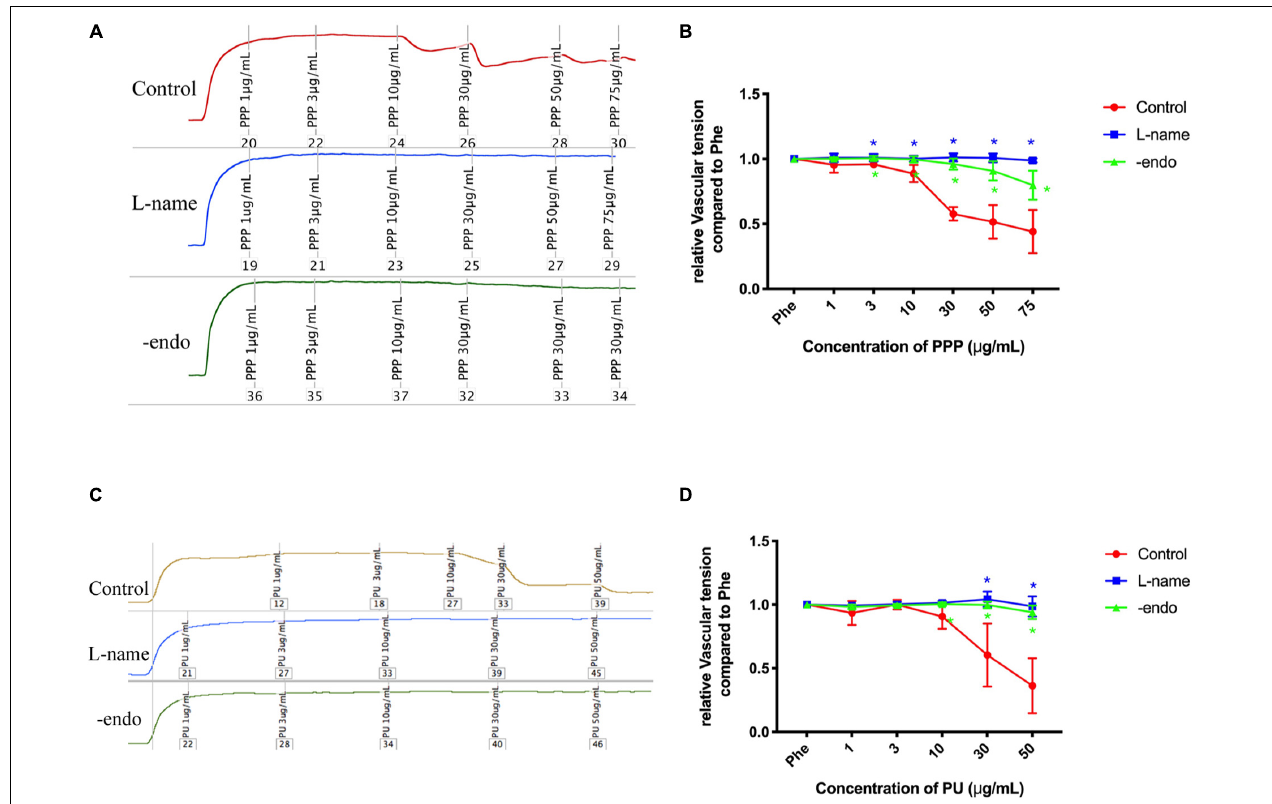
FIGURE 3 | Endothelium-dependent vaso-protective effects of PPP and PU. A-D. Endothelium-dependent vaso-protective effects of PPP (A) and PU (C) and the quantitative results [ (B,D) , respectively], including n = 4–6 biological replicates. * P < 0.05 vs. Control.